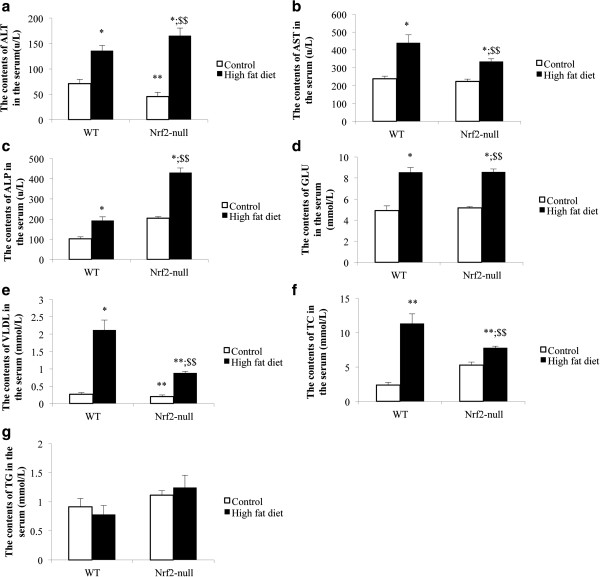
Comparison of Nrf2 with respect to plasma laboratory tests; a. The contents of ALT in the serum; b. The contents of AST in the serum; c. The contents of ALP in the serum; d. The contents of GLU in the serum; e. The contents of VLDL in the serum; f. The contents of TC in the serum; g. The contents of TG in the serum. ALT, alanine transaminase; AST, aspartate transminase; ALP, alkaline; GLU, glucose; VLDL, very low density lipoprotein; TC, total cholesterol; TG, triglyceride.